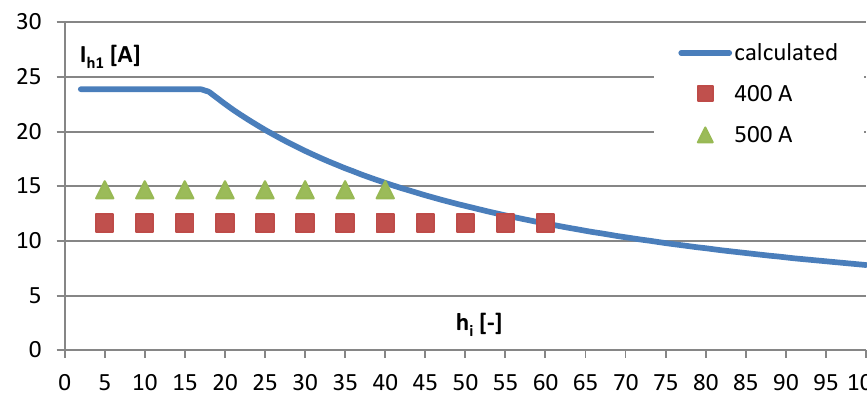
Figure 13. The frequency band of operation of the power source with an audio amplifier for a required rms value of its main component of the output current.